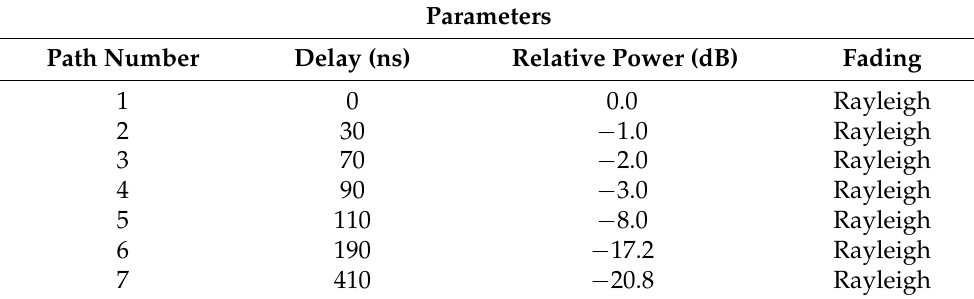
Table 1. EPA channel model